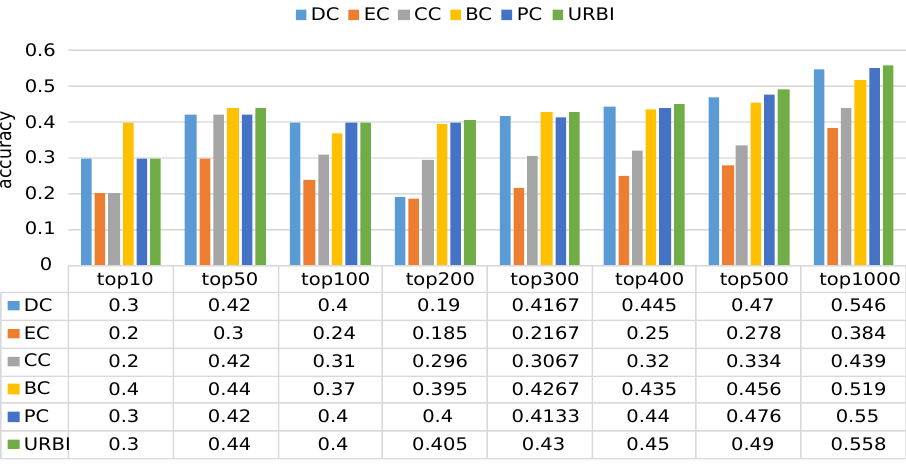
Figure 6. This figure depicts the experimental results of dataset No.6, which contains 7435 book